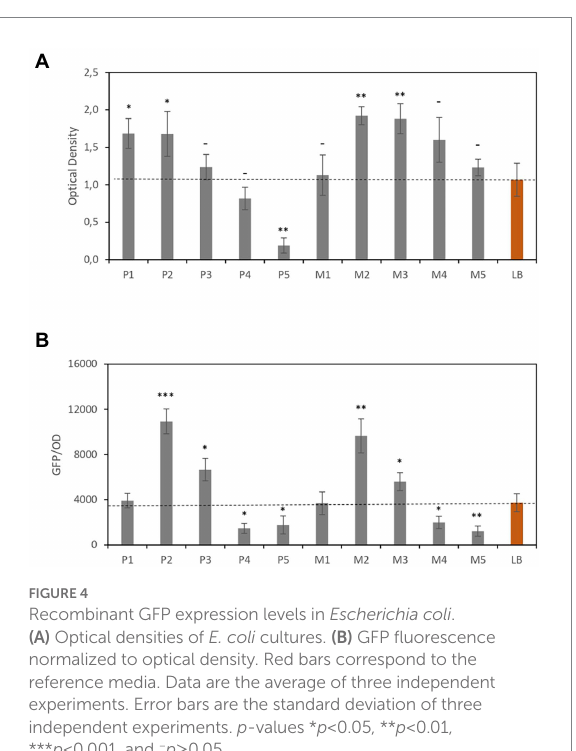
FIGURE 4 Recombinant GFP expression levels in Escherichia coli . (A) Optical densities of E. coli cultures. (B) GFP fluorescence normalized to optical density. Red bars correspond to the reference media. Data are the average of three independent experiments. Error bars are the standard deviation of three independent experiments. p -values * p < 0.05, ** p < 0.01, *** p < 0.001, and – p ≥ 0.05.